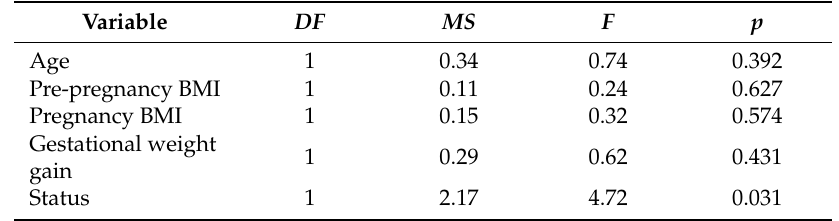
Table 3. ANCOVA analysis of leukocyte SIRT1 expression between the GDM and NGT groups (Status) with adjustment for age and obesity variables (pre- and pregnancy BMI and gestational weight gain). Variable